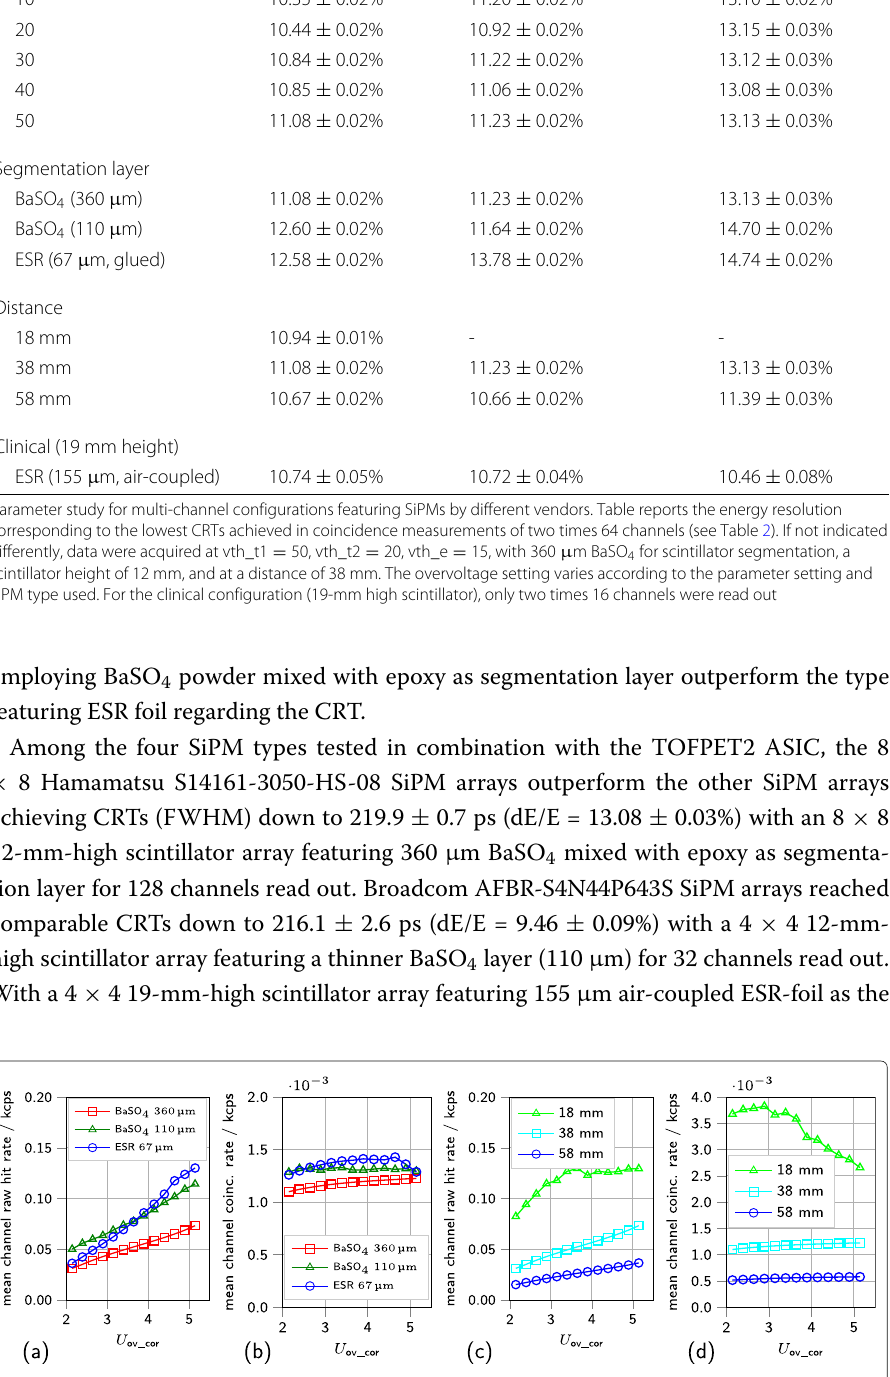
Fig. 7 Data rates for different setup hardware configurations. a Mean raw hit rate per channel for different reflector materials. b Mean coincidence rate per channel for different reflector materials. c Mean raw hit rate per channel for different distances of the detectors to the source. d Mean coincidence rate per channel for different distances of the detectors to the